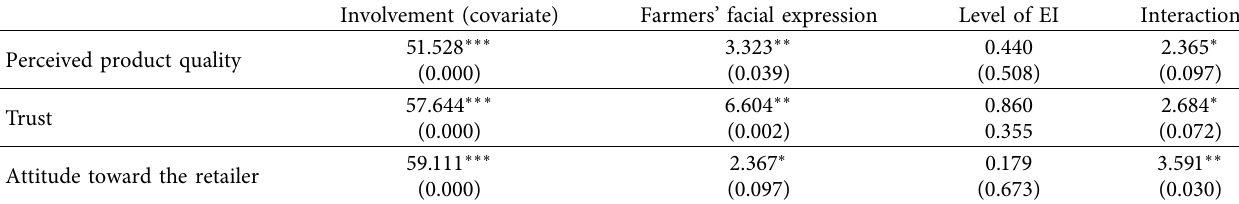
Table 3: Analysis of covariance (ANCOVA) results.